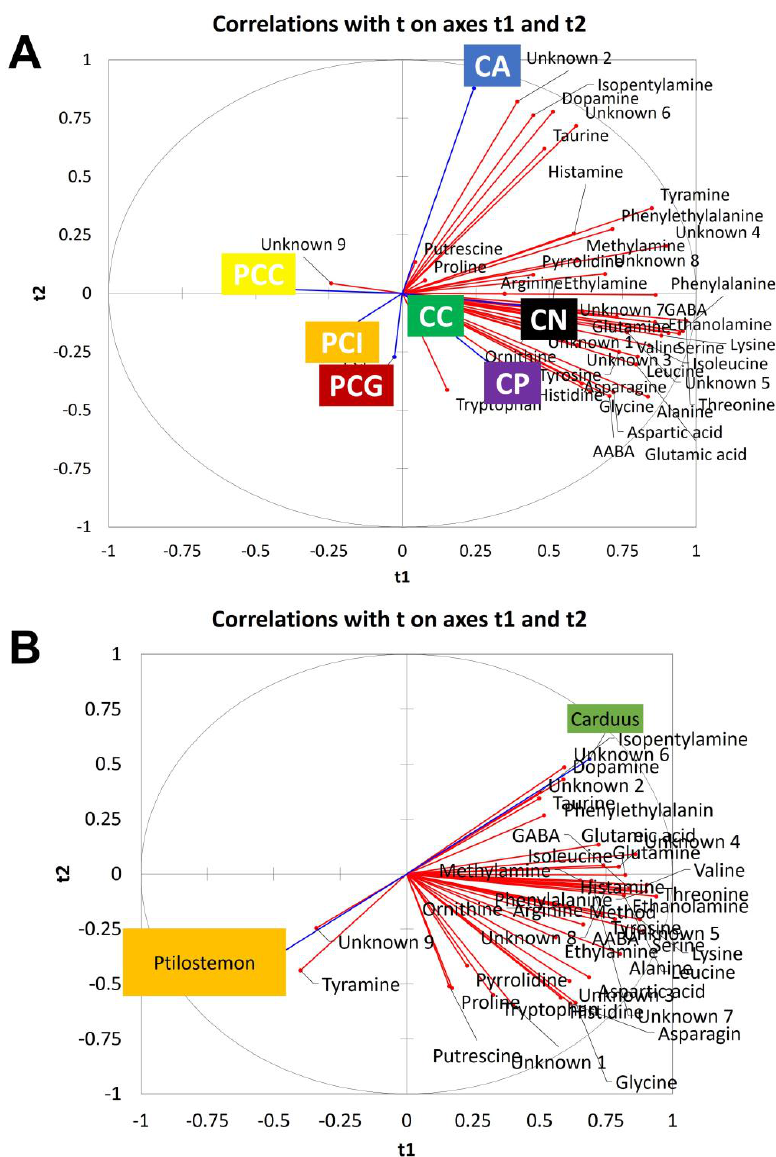
Figure 3. Partial least-squares discriminant analysis (PLS-DA) 42 Cardueae samples (six individuals for each species/locality) based on peak areas in NL scan mode of 41 informative compounds selected as variables: ( A ) score plot of samples grouped by the species/locality of belonging ( B ) score plot of samples grouped by the genus of belonging. CA: C. argyroa ; CC: C. cephalanthus ; CN: C. nutans subsp